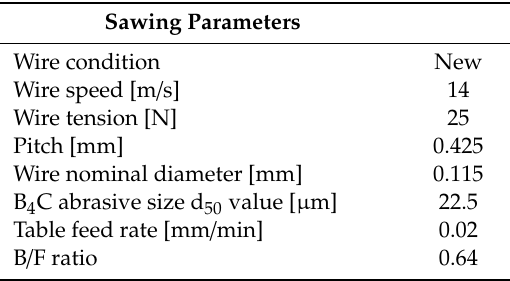
Table 2. Common process parameters.